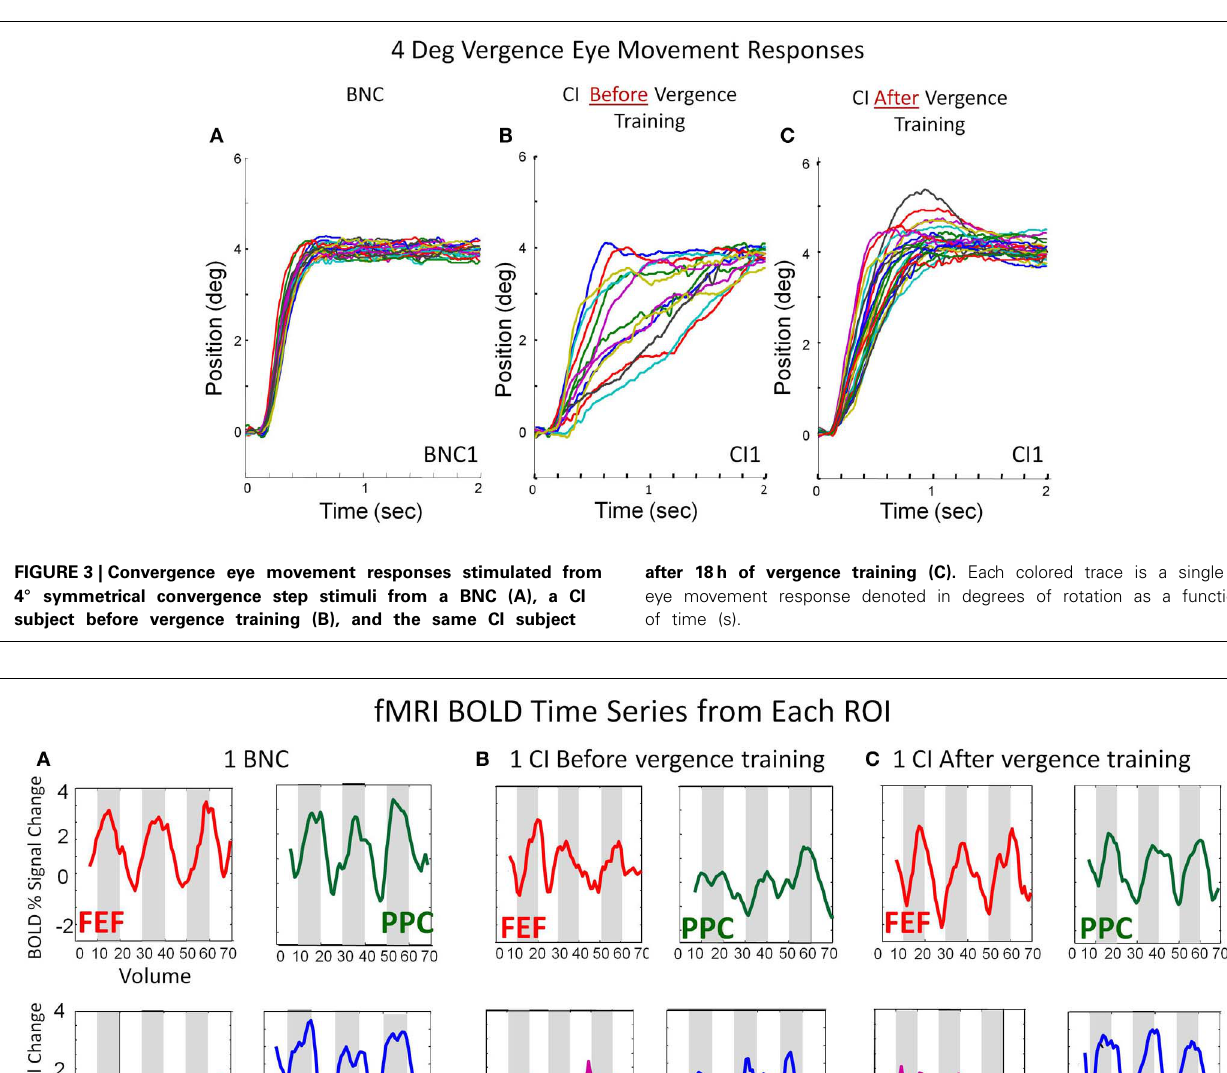
The BOLD signal is plotted as the percent signal change as a function of volume. The time of repetition was 2s. Hence, the time series lasts for a duration of